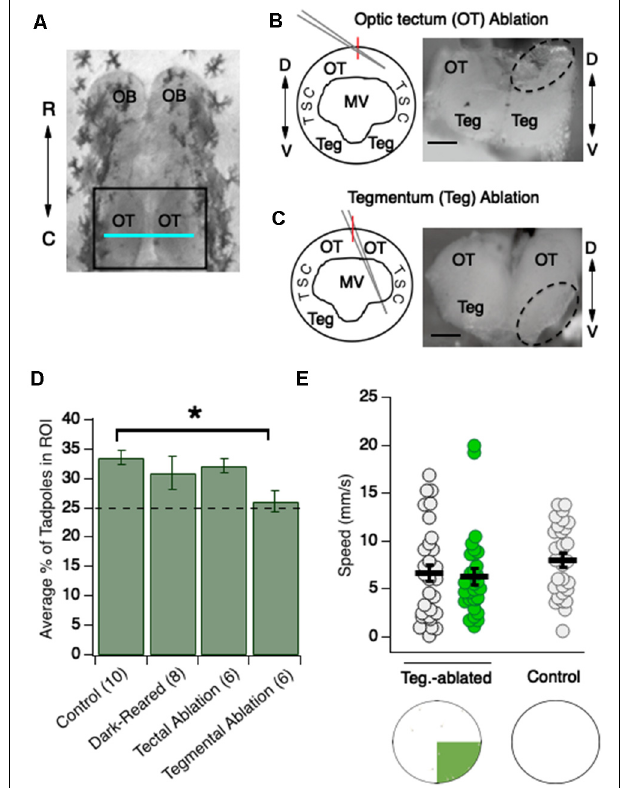
FIGURE 3 | Ablation studies indicate that the preference for the green region of the dish requires the tegmentum but not the OT. (A) Overhead view of stage 48 tadpole brain. OT (region inside black square) is a major component of the amphibian midbrain; the blue horizontal line indicates the approximate position along the rostrocaudal axis at which the OT is most extensive. The tegmentum resides directly ventral to this region of the OT, and so is not visible in this image. OB, olfactory bulb; OT, optic tectum; R, rostral; C, caudal. ( B , schematic) Cross-section of this region. The dorsal optic tectum and ventral tegmentum are separated in space by the large MV. For optic tectum ablations, the pipette is advanced at an oblique angle to ablate specifically the OT; ( B , micrograph) cross-section showing an ablated tectal lobe. D, Dorsal; MV, Middle Ventricle; TSC, torus semicircularis; Teg, Tegmentum. ( C , schematic) Cross-section showing that for tegmentum ablations, the pipette is advanced at a steeper angle. ( C , micrograph) Cross-section showing an ablated tegmentum. The dashed-line-enclosed regions are the regions that have been ablated. Here, only one hemisphere is ablated to readily compare “normal” and “ablated” structures. For the experiments, both hemispheres are ablated. Red vertical lines on the schematics indicate the midline. Scale bar = 100 µ m for both images. (D) Bar graph summarizing the effects of dark-rearing, tectal ablation, and tegmental ablation (* p < 0.05). Only the tegmental-ablated show a significant loss in preference for green compared to controls. (E) Dot plots showing swimming speeds of tegmentum-ablated tadpoles while in the white and green region of the test dish, and speeds of control tadpoles in an all-white dish. Each dot represents an individual tadpole’s swimming speed. Notice that average swimming speeds for tegmental-ablated tadpoles are similar across the green and white test dish, and are also similar to swimming speeds of control tadpoles in an all-white dish.